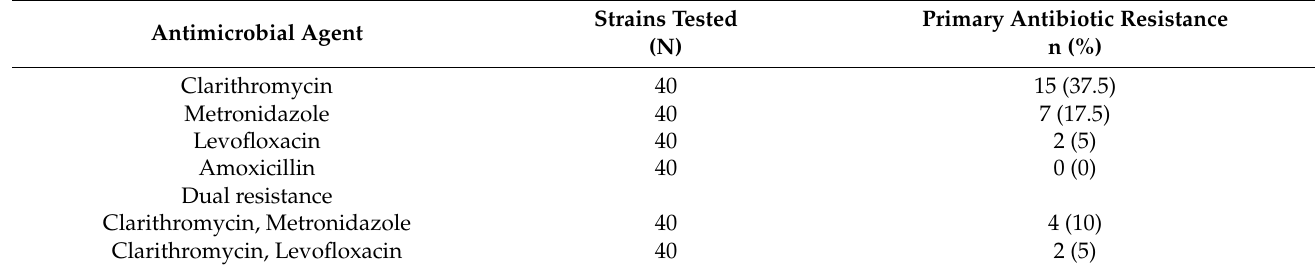
Table 3. Antimicrobial resistance in the study population.